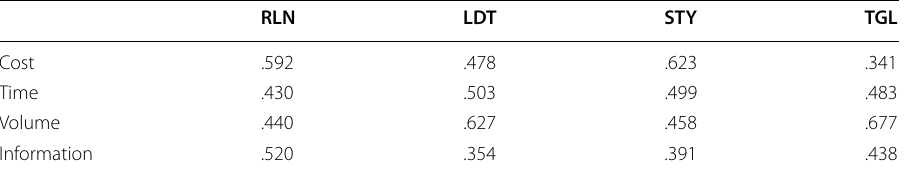
Table 14 Normalized matrix